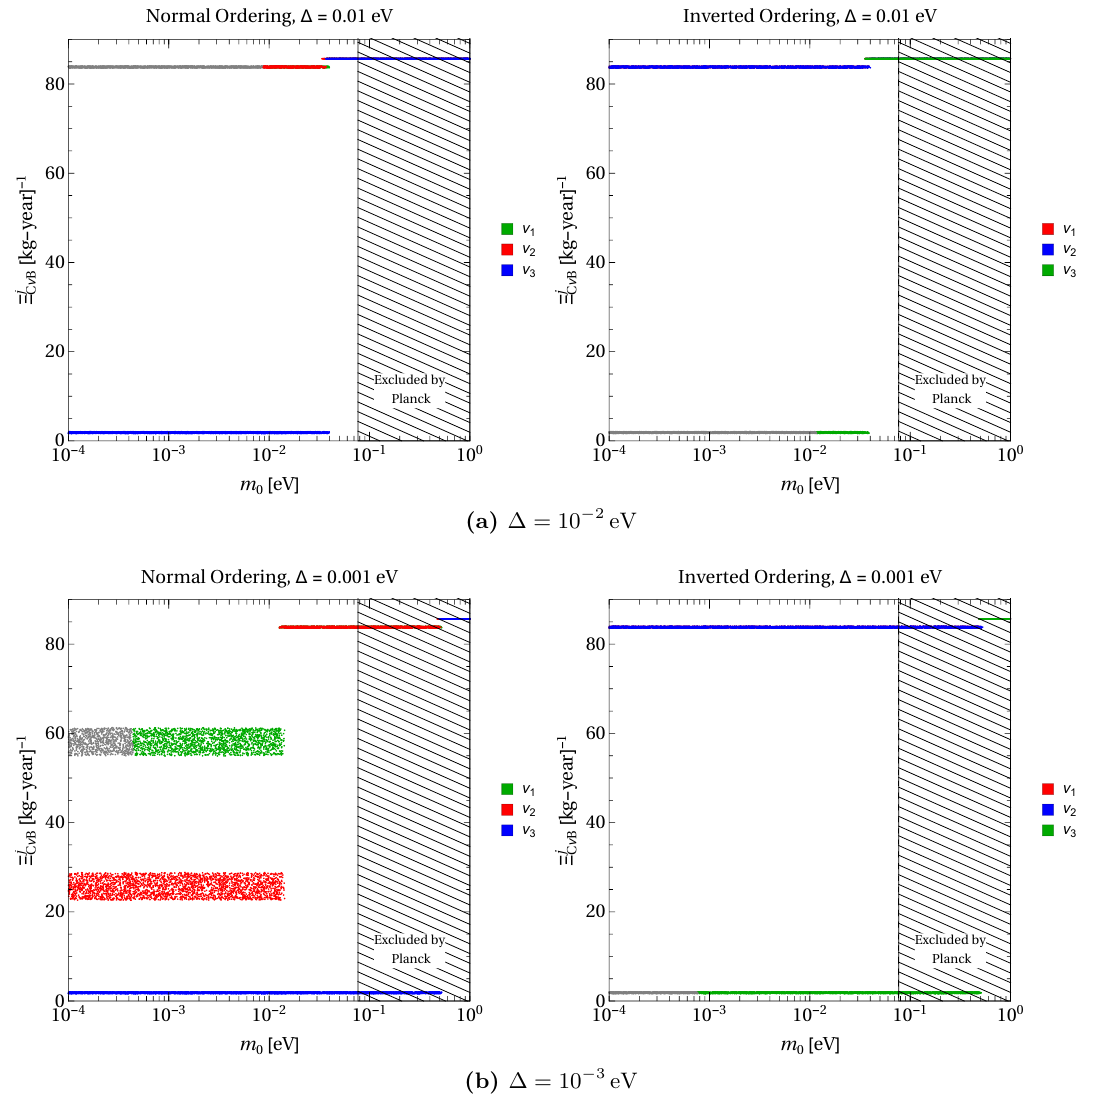
Figure 3. Dependence of the (cid:4) j function of eq. (A.2) on the value of the lightest neutrino C (cid:23) B mass m 0 . The experimental resolution is chosen to be (cid:1) = 0 : 01 eV (upper panels) and (cid:1) = 0 : 001 eV (lower panels), and we show both normal ordering (left panels) and inverted ordering (right panels). The three neutrino mass eigenstate contributions are shown in green ( (cid:23) 1 ), red ( (cid:23) 2 ) and blue ( (cid:23) 3 ). The gray points correspond to the regions that cannot be distinguished from the (cid:12) -decay background. The shaded region is excluded by the Planck limit on the sum of neutrino masses